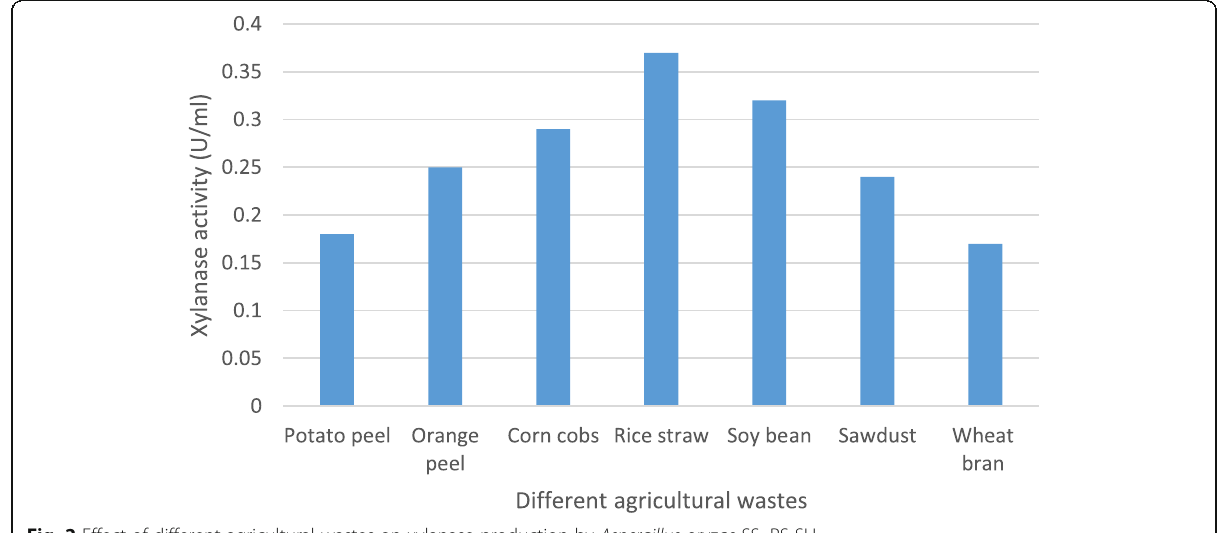
Fig. 2 Effect of different agricultural wastes on xylanase production by Aspergillus oryzae